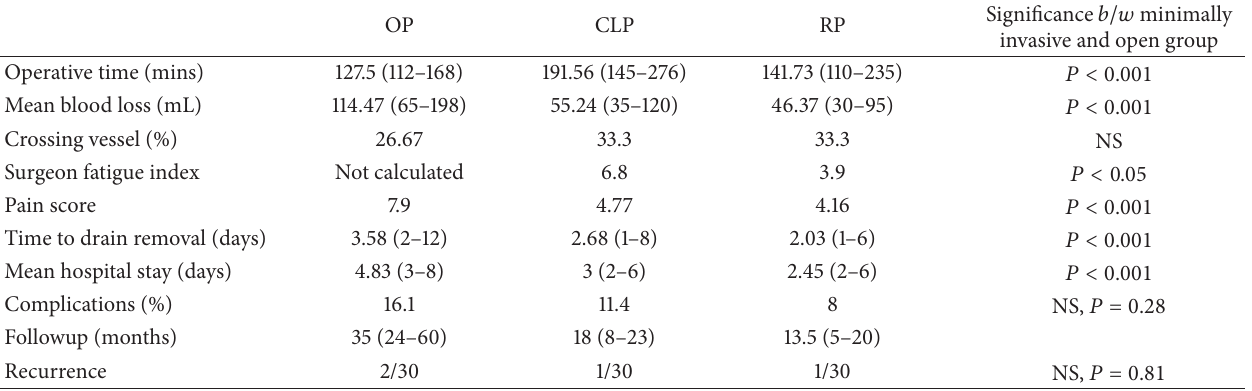
Table 2: Perioperative and postoperative outcomes in the three groups and the significance indifference between minimally invasive group and OP group. 𝑃 < 0.05 was considered